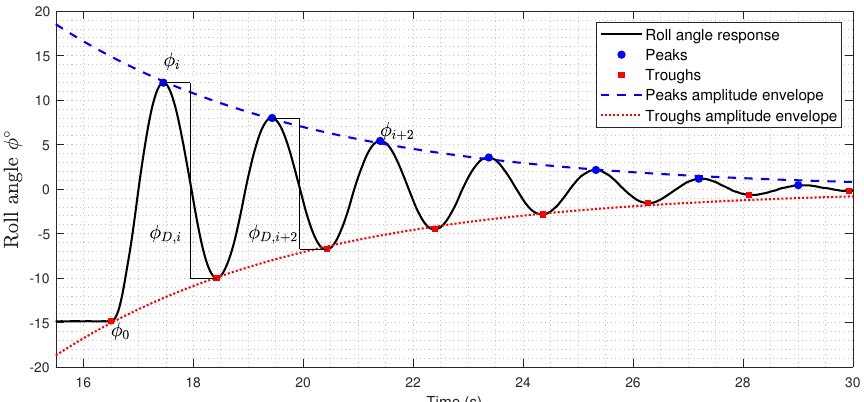
Figure 1. Roll angle decay response with peaks and double amplitudes annotations test case 8, see Section